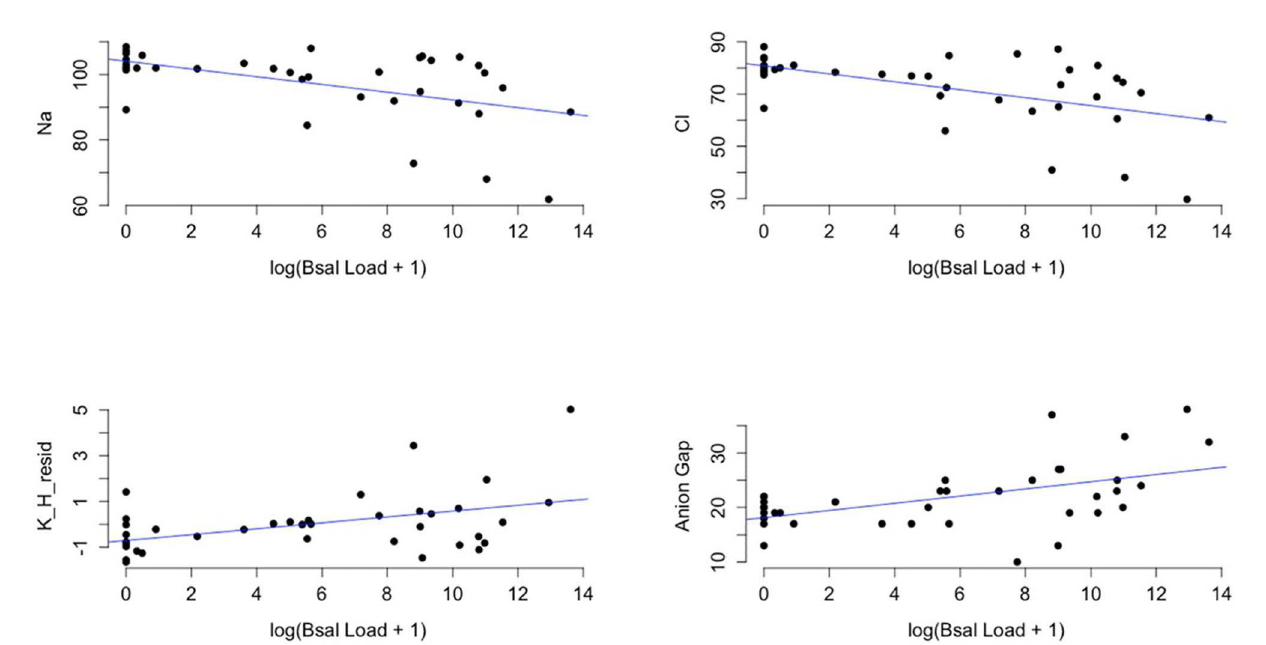
FIGURE6 Plots of sodium (Na), chloride (Cl), the residuals of potassium (K) regressed on hemolytic index (H) (K_H_resid), and anion gap (y-axis) and the log of Batrachochytrium salamandrivorans qPCR load at time of necropsy + 1 (x-axis). Black points are observed data points and blue lines are best-fit regression lines for visual reference of the dominant trend in the data. Additional analysis showed that there was significant evidence for a non-linear quadratic effect of log( Bsal Load + 1) on biochemical variables (log( Bsal Load + 1) 2 (effect from PERMANOVA: F = 6.98, p = 0.001).